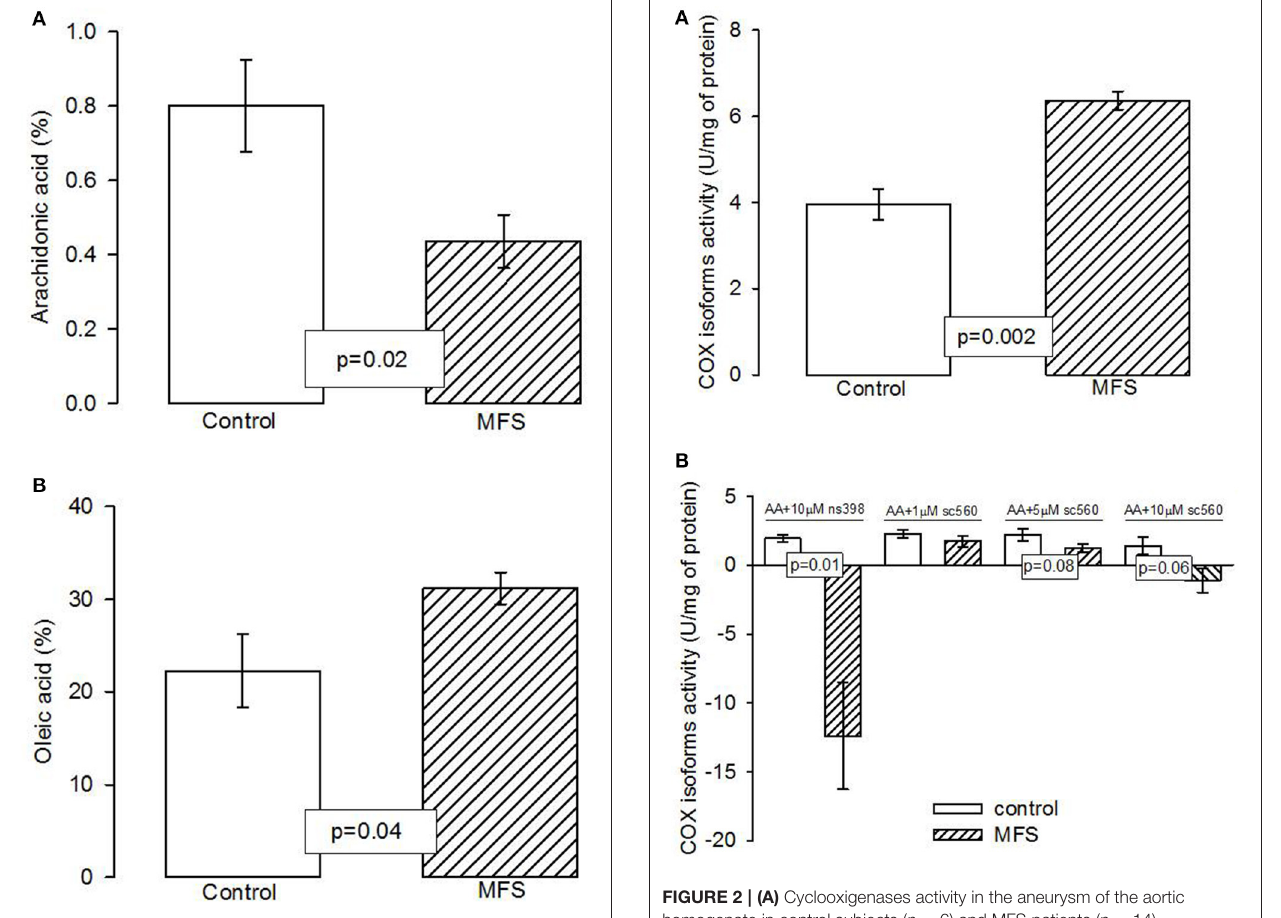
FIGURE 1 | Total arachidonic acid percentage concentration (A) and of total oleic acid concentration (B) in the aortic aneurysm homogenate in control and MFS patients ( n = 6; n = 14). The values are means ± SE. AA, Arachidonic acid; MFS, Marfan syndrome.